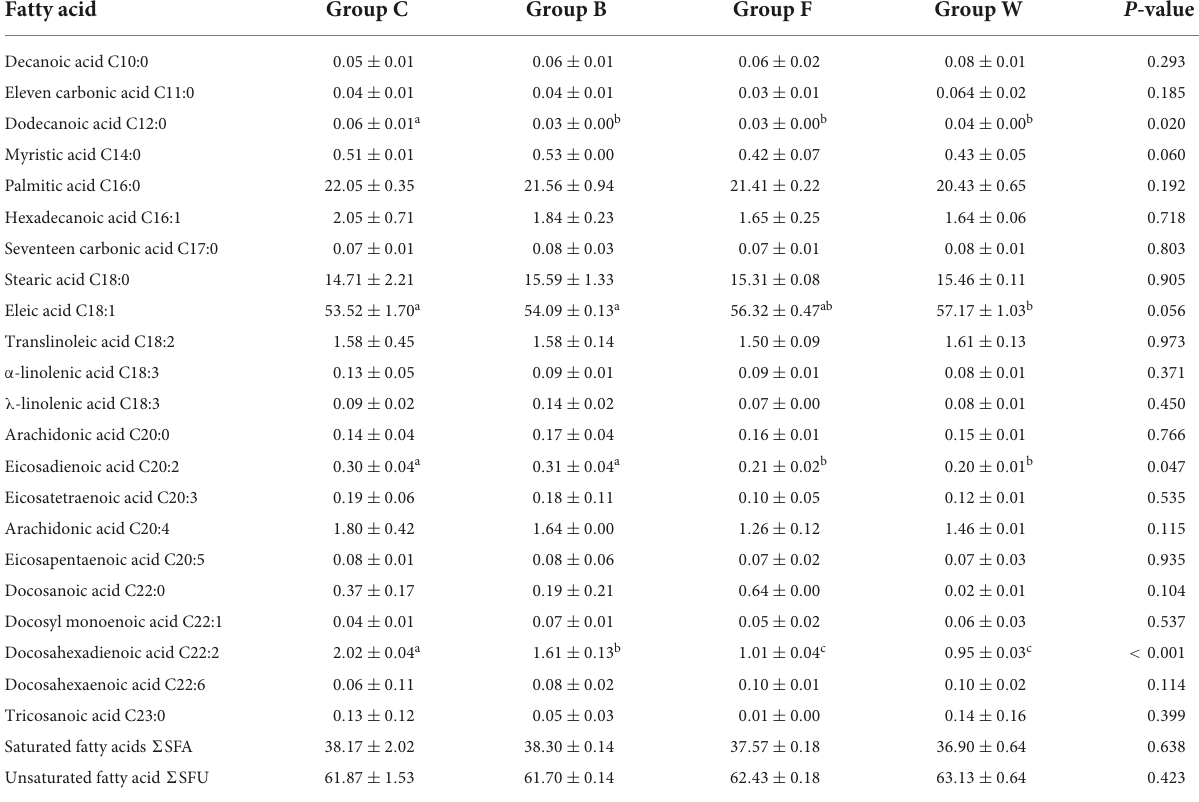
TABLE 6 Effects of brewers’ spent grain (BSG) on the compositions of fatty acids in the livers of four groups of Landes geese (i.e., groups C, B, F, and W) in 90